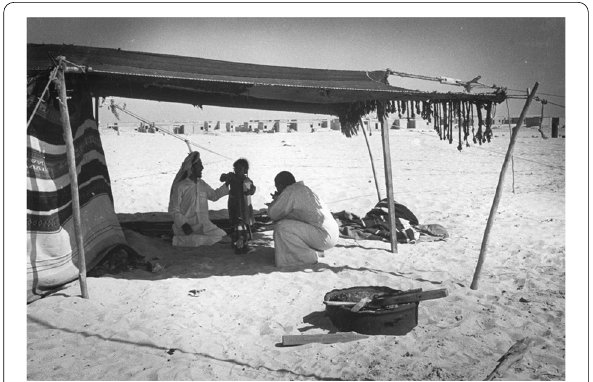
Fig. 5 A traditional tent bait al shaar in the foreground; in the backdrop a sha’abi housing under construction in 1974. Photo: © Gerard Klijn/Katholiek Documentatie Centrum